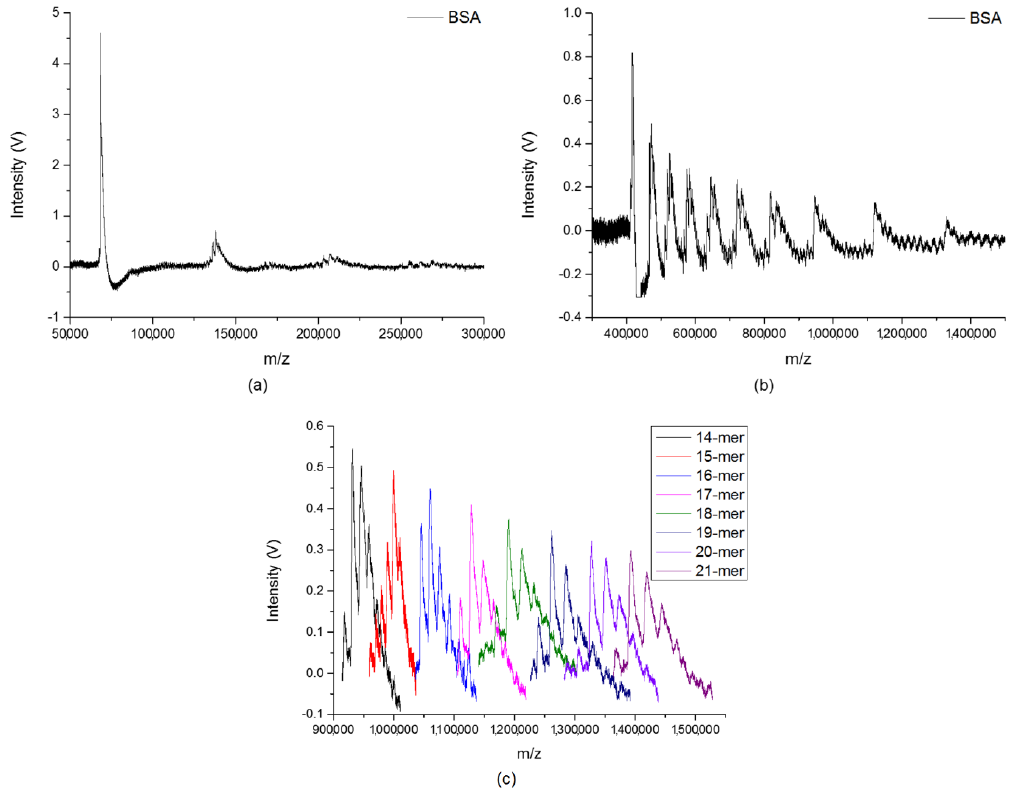
Figure 5. ( a ) The BSA clusters in low-mass region. ( b ) BSA clusters with m / z from 300 kDa to 1500 kDa. ( c ) Signals of specific BSA cluster with various sizes (14-mer to 21-mer) in very high mass region under eight different ranges of scanning frequencies, respectively. The gap between each size of BSA clusters is around 66